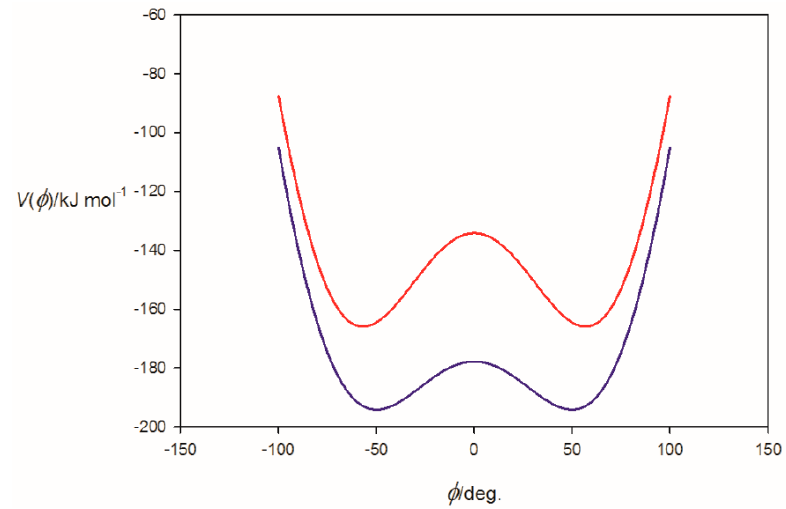
Figure 6. Variation of the electrostatic potential V ( φ ) with angle φ at the distance r = 1.6 Å from the O atom of oxetane (blue curve) and oxirane (red curve).